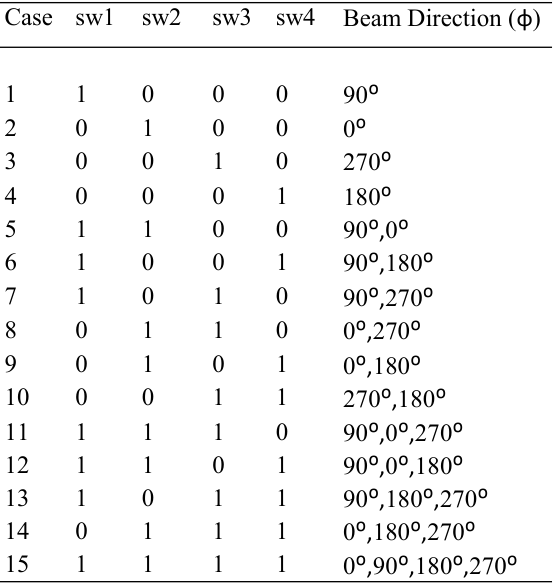
Table 1: Beam switching configurations.